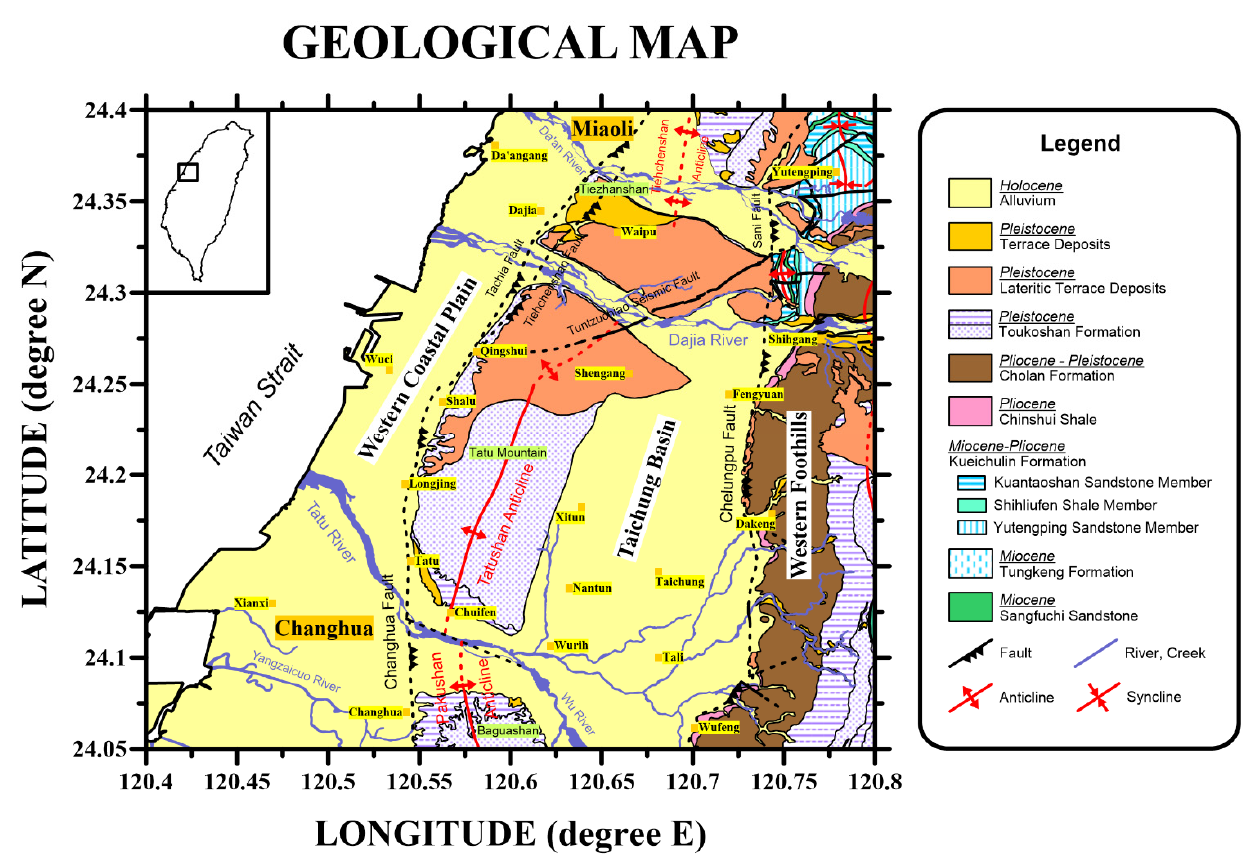
Figure 1. Geological map of the Taichung area (reconstructed from Central Geology Survey [ 2 ]).